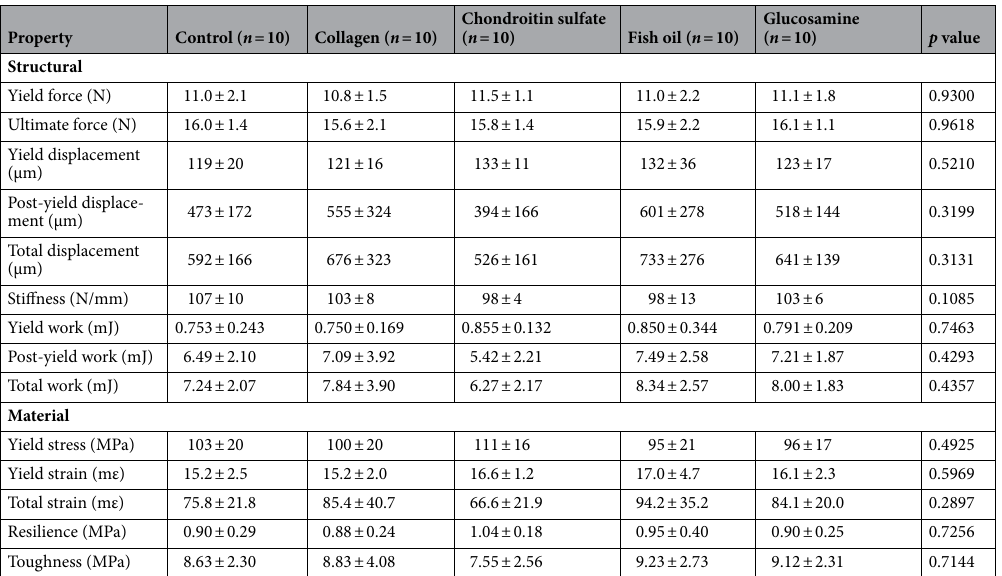
Table 2. Mechanics of femurs. Asterisks indicate significant differences when compared to control group. All values are reported as average ± standard deviation. Overall ordinary one way ANOVA or Kruskal Wallis p values are reported.